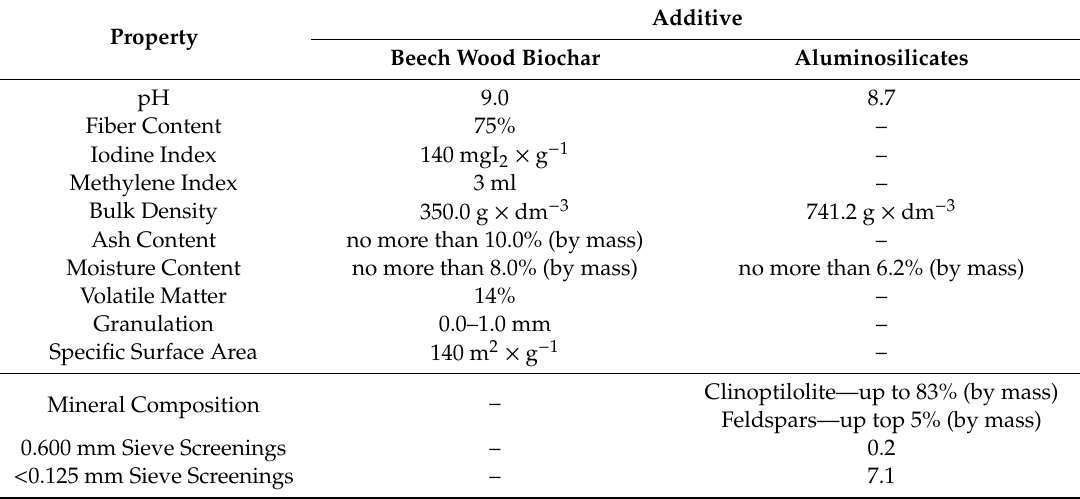
Table 1. Properties of additives used in the